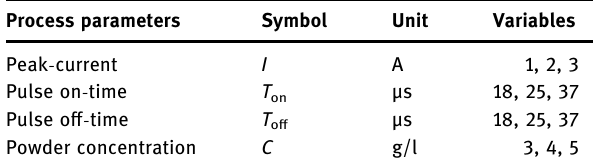
a digital weighing scale with an accuracy of 0.001 g and a standard deviation of 10 mg ( Model: Vibra AJ - 203